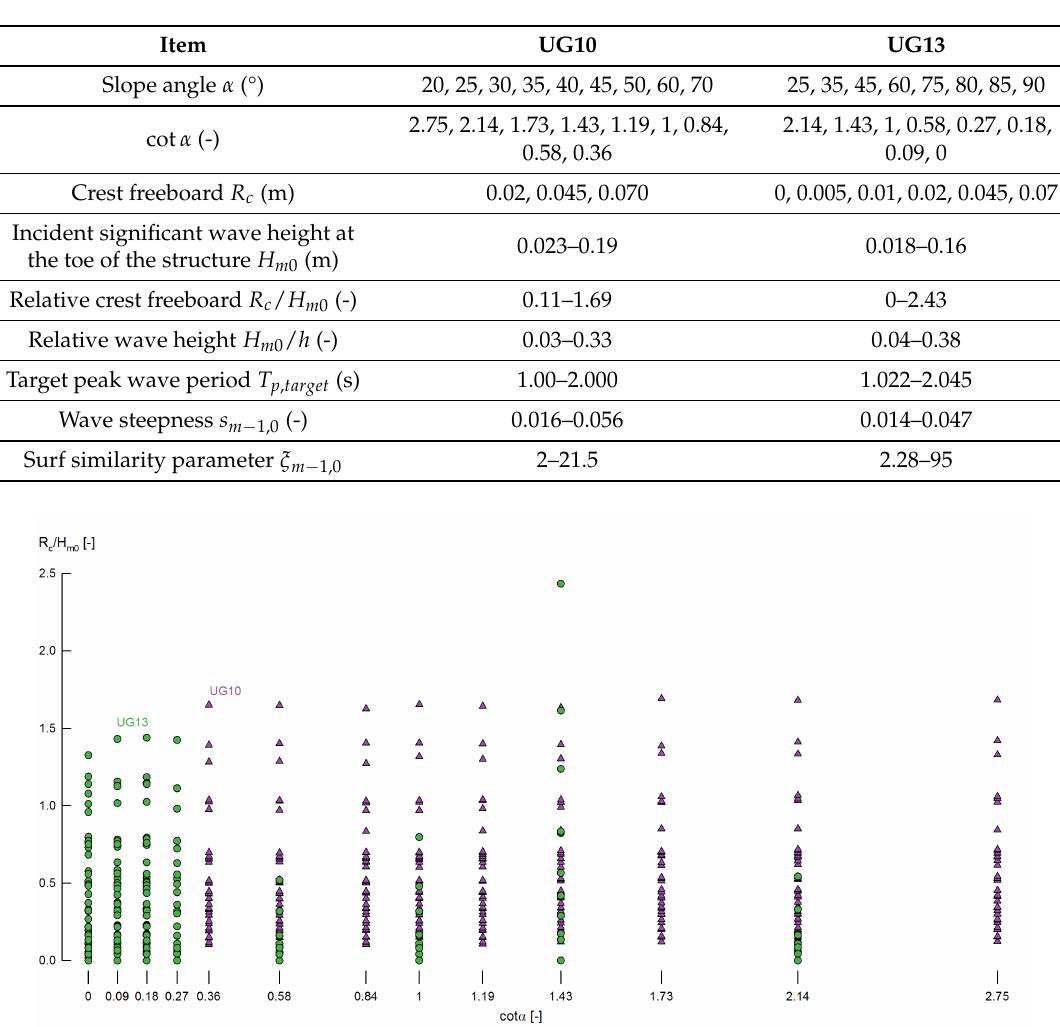
Figure 6. Slope angle cot α and relative crest freeboard R c / H m 0 values tested on the UG10 (purple triangles) and UG13 (green circles)